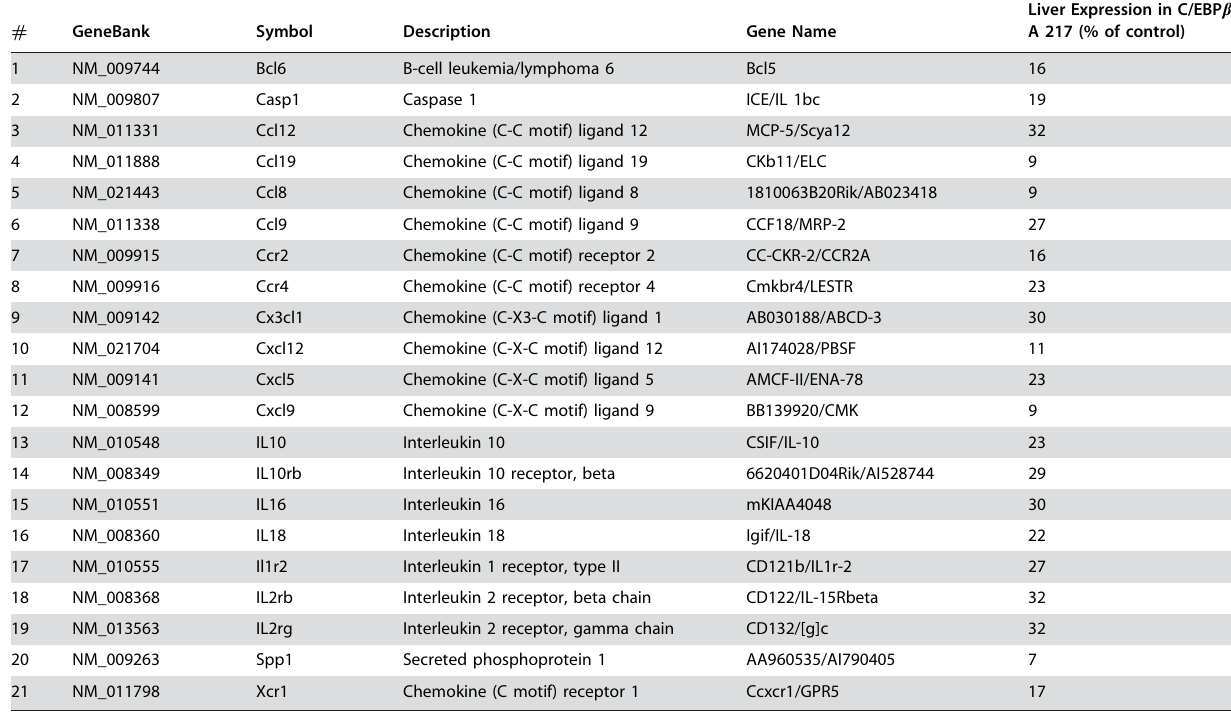
Table 1. Decreased Inflammation in the Livers of C/EBP b - Ala217 mice after CCl 4 treatment. .. ... .... ... ... .... ... ... .... ... ... .... ... ... .... ... ... .... ... ... .... ... ... .... ... ... .... ... ... .... ... ... .... ... ... .... ... ... .... ... ... .... ... ...